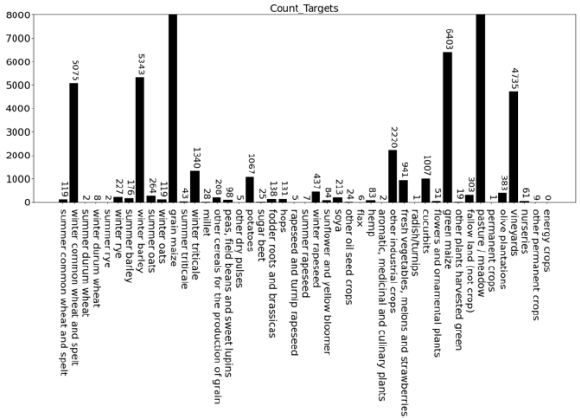
Figure 4. Number of samples per crop class in the testing dataset. For visualization purposes the y axis is limited to 8000. Two classes are more numerous: grain maize (9047 samples) and pasture / meadow (77684 samples).